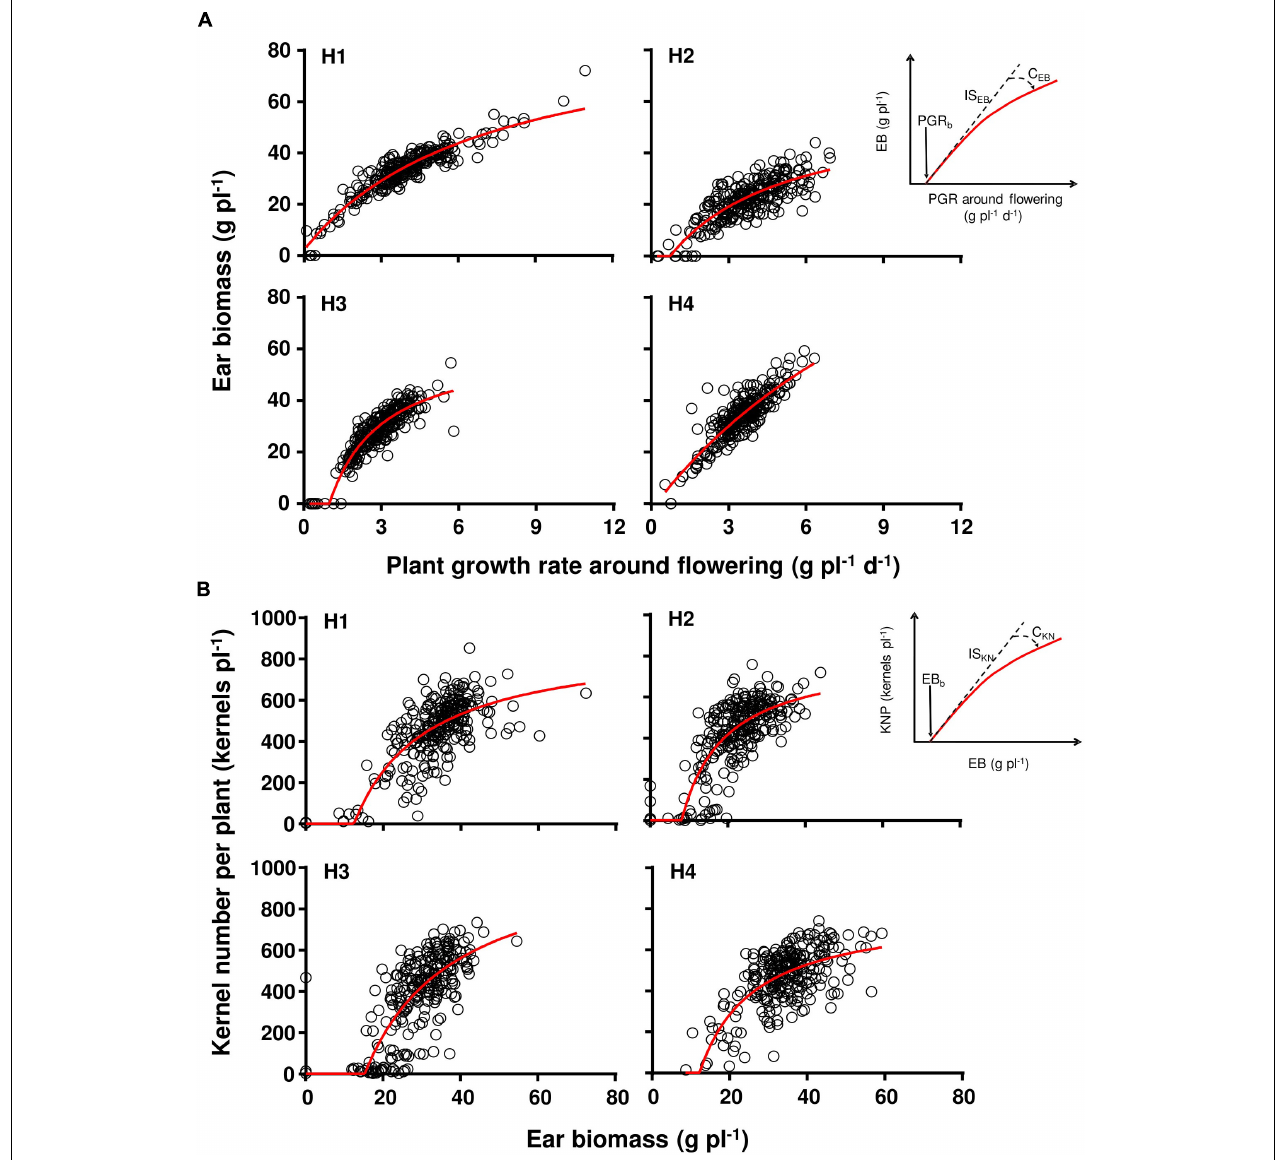
FIGURE 1 | Ear biomass as a function of plant growth rate (A) , and kernel number as a function of ear biomass (B) for the four evaluated genotypes (H1, H2, H3, and H4). The left inset in (A,B) describe the parameters for each relationship, fully described in Table 3 . All correlations were significant [ (A) H1 had n = 263, r 2 = 0.54; H2 had n = 261, r 2 = 0.59; H3 had n = 252, r 2 = 0.55; H4 had n = 259, r 2 = 0.45; in (B) H1 had n = 265, r 2 = 0.88; H2 had n = 270, r 2 = 0.65; H3 had n = 269, r 2 = 0.84; H4 had n = 268, r 2 = 0.75]. Red lines describe the fitted